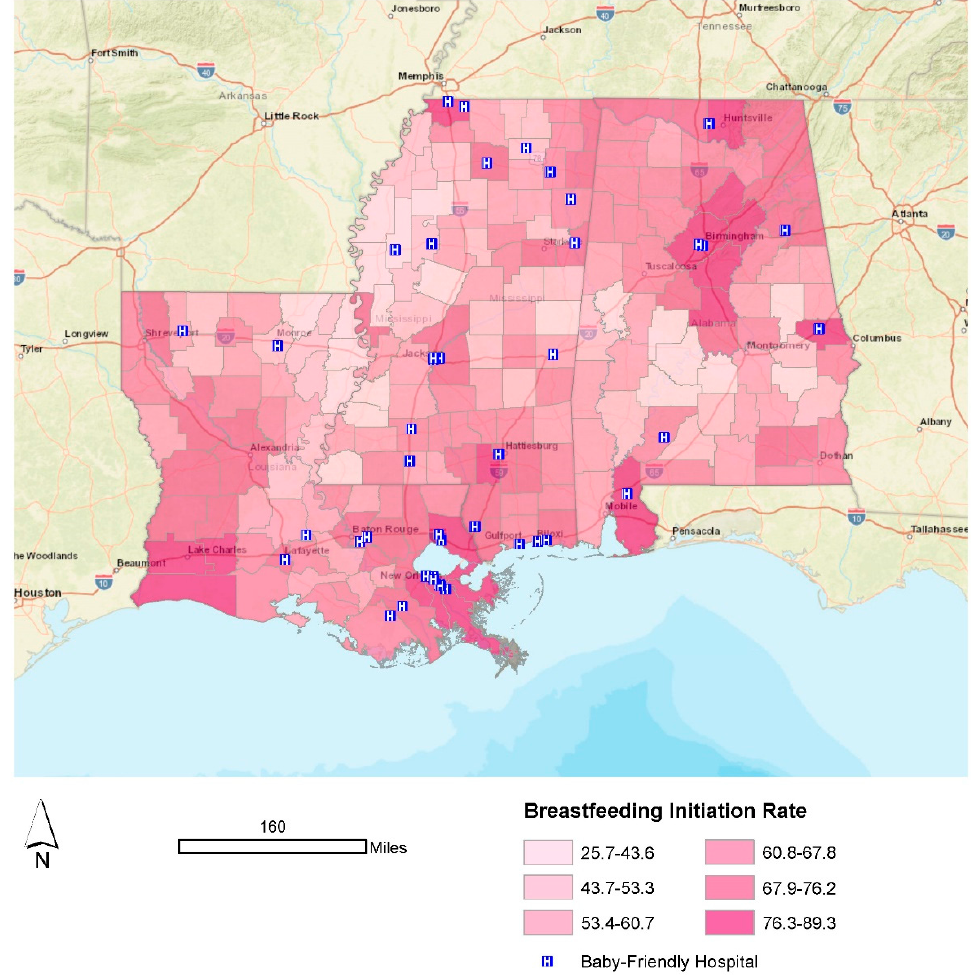
Figure 2. Breastfeeding initiation rate: 2018–2019.